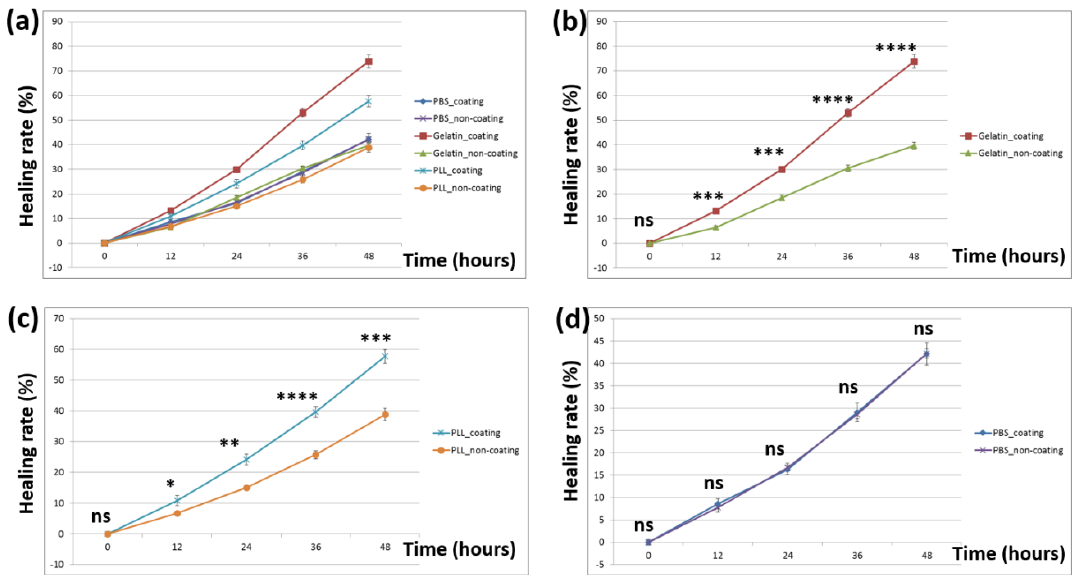
Figure 8. ( a ) Calculated wound-healing rates under all conditions. Statistical analysis was performed on nine independent data points (see Section 2.5). Student’s t-tests were performed between ( b ) gelatin-coated and uncoated surfaces, ( c ) poly-L-lysine-coated and uncoated surfaces, and ( d ) PBS-coated and uncoated surfaces. ns: no statistically significant difference (p > 0.05); *: p < 0.05; **: p < 0.01; ***: p < 0.001; ****: p < 0.0001.